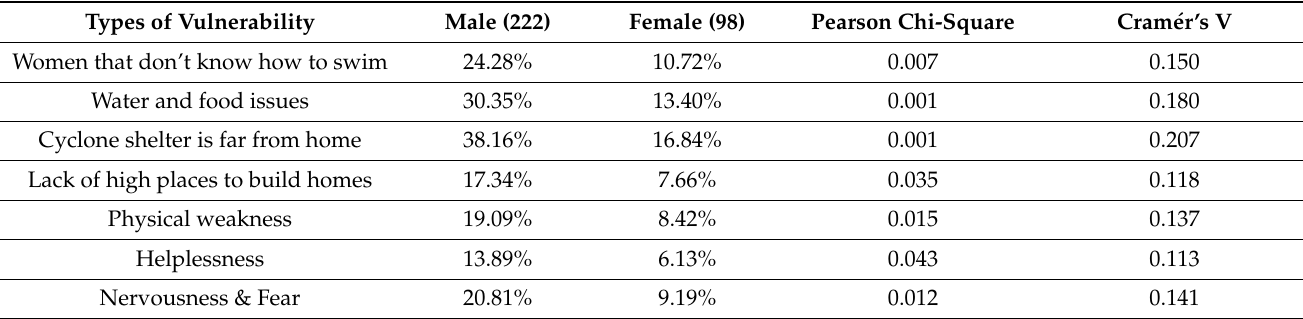
Table 12. Refer back to Table 5. the impacts of climate change on gender in particular.